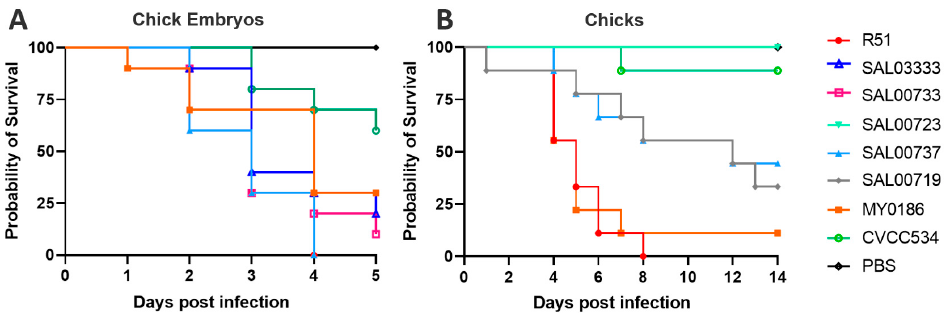
Figure 1. Virulence assays of S. Pullorum R51 and additional seven S. Pullorum clinical isolates in 16- day-old chick embryos and 1-day-old chicks. ( A ) Chick Embryos, ( B ) Chicks. 16-day-old chick embryos and 1-day-old chicks. ( A ) Chick Embryos, ( B ) Chicks.